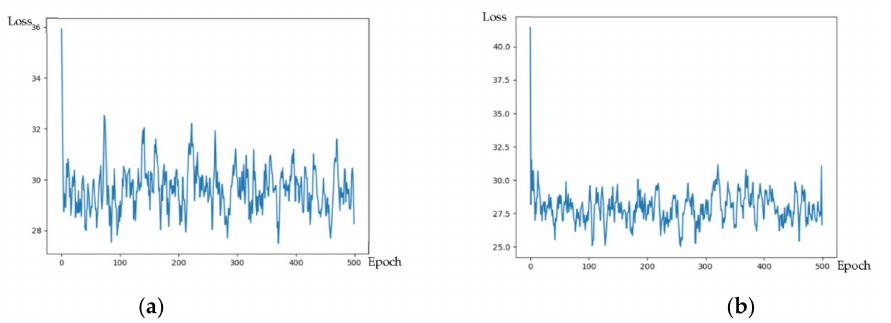
Figure 9. Comparison of loss before and after improvement. ( a ) Loss of DeepLabv3+. ( b ) Loss of our